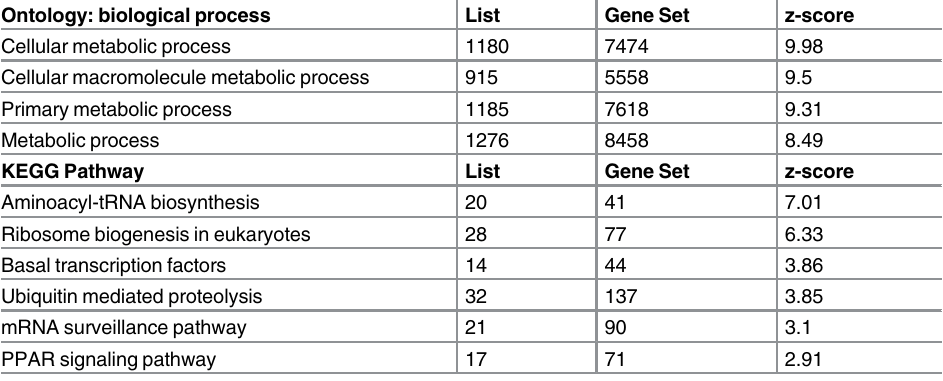
Table 3. Gene Ontology and KEGG report of down-regulated gene pathways. Ontology: biological process List Gene Set z-score Cellular metabolic process 1180 7474 9.98 Cellular macromolecule metabolic process 915 5558 9.5 Primary metabolic process 1185 7618 9.31 Metabolic process 1276 8458 8.49 KEGG Pathway List Gene Set z-score Aminoacyl-tRNA biosynthesis 20 41 7.01 Ribosome biogenesis in eukaryotes 28 77 6.33 Basal transcription factors 14 44 3.86 Ubiquitin mediated proteolysis 32 137 3.85 mRNA surveillance pathway 21 90 3.1 PPAR signaling pathway 17 71 2.91 The List value is the number of affected genes from the gene set within a pathway. The Gene set value shows the total number of genes from the dataset that are in each gene ontology category. The z-score in the GO and KEGG reports above 2 indicates the term occurs more frequently than expected by